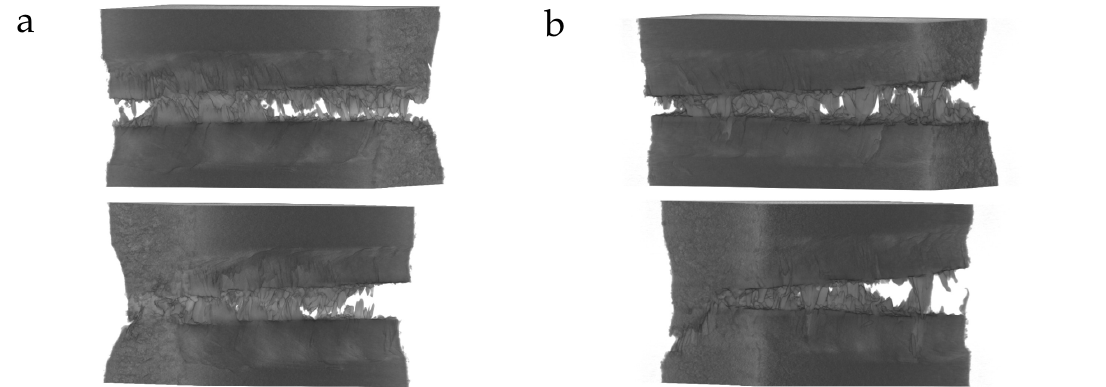
Figure 17. 3D rendering of fracture in AISI430Ti after ( a ) 10h and ( b ) 20h exposure to the corrosive environment, obtained by µ -CT analysis. Top images: front view, bottom images: rear